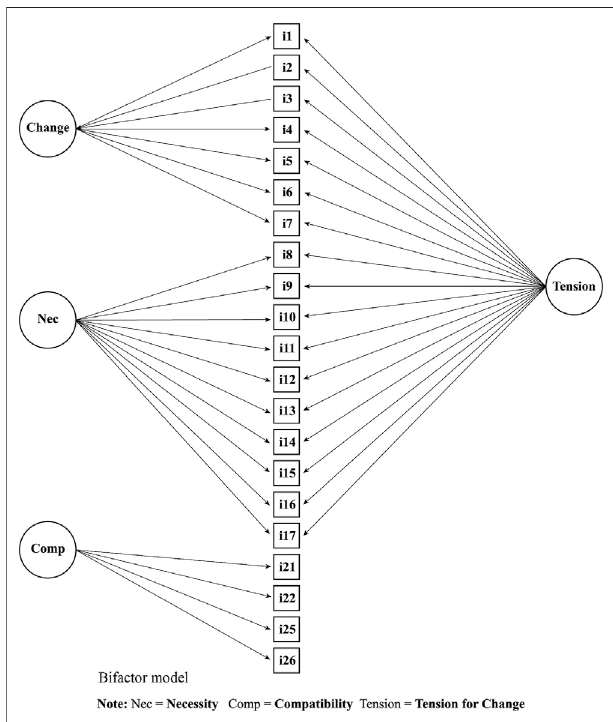
FIGURE 1 | Bifactor model of the Implementation Climate survey.